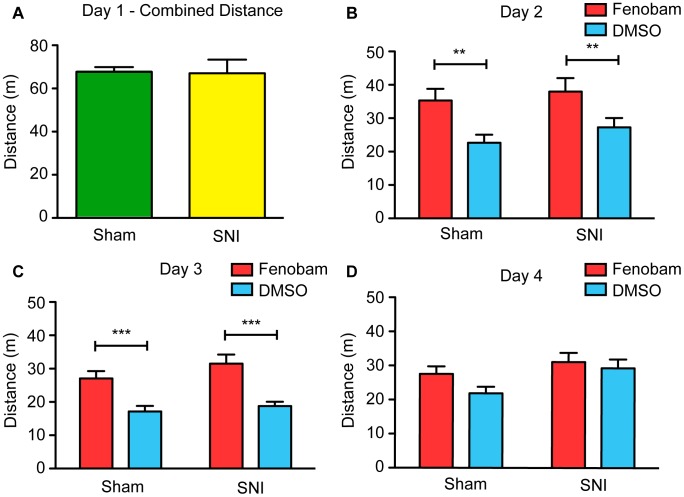
Male SNI and sham mice travel similar distances and show tolerance to locomotor side-effects.(A) SNI (n = 15) and sham (n = 15) mice travel a similar distance in both outer chambers of the aCPP apparatus on preconditioning day 1. (B) On conditioning day 2 and (C) conditioning day 3, both SNI and sham mice are hyperactive when treated with fenobam. Mice were restricted to only one of the outer chambers when these measurements were taken. (D) However, by day 4, neither group of mice show increased distance traveled in the fenobam chamber compared to the vehicle-paired chamber. Two-way ANOVA followed by Bonferroni post hoc test, **p<0.01, ***p<0.001.